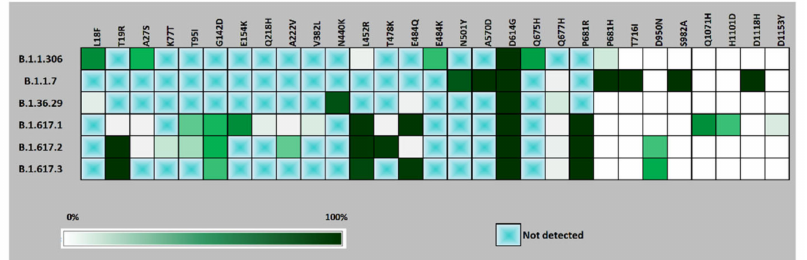
Figure 3. Heat map of major mutations in the spike protein of the predominant lineages from Novem- ber, 2020 to May, 2021. A box with a green cross indicates that the specific mutation was